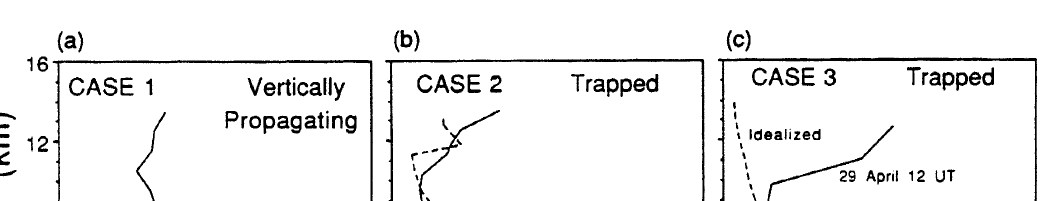
Fig. 9. Di(cid:128)erence between wind and wave azimuth in degrees measured over the Welsh mountains (from Worthington, 1999b, Copyright American Geophys. Union)